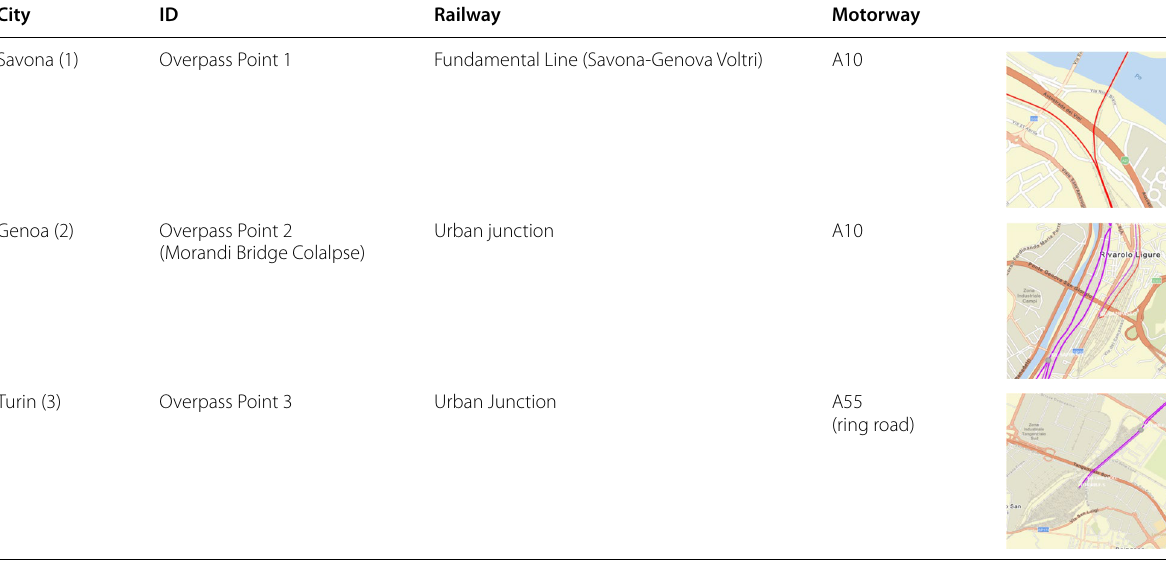
Table 3 Selected Major overpass points: